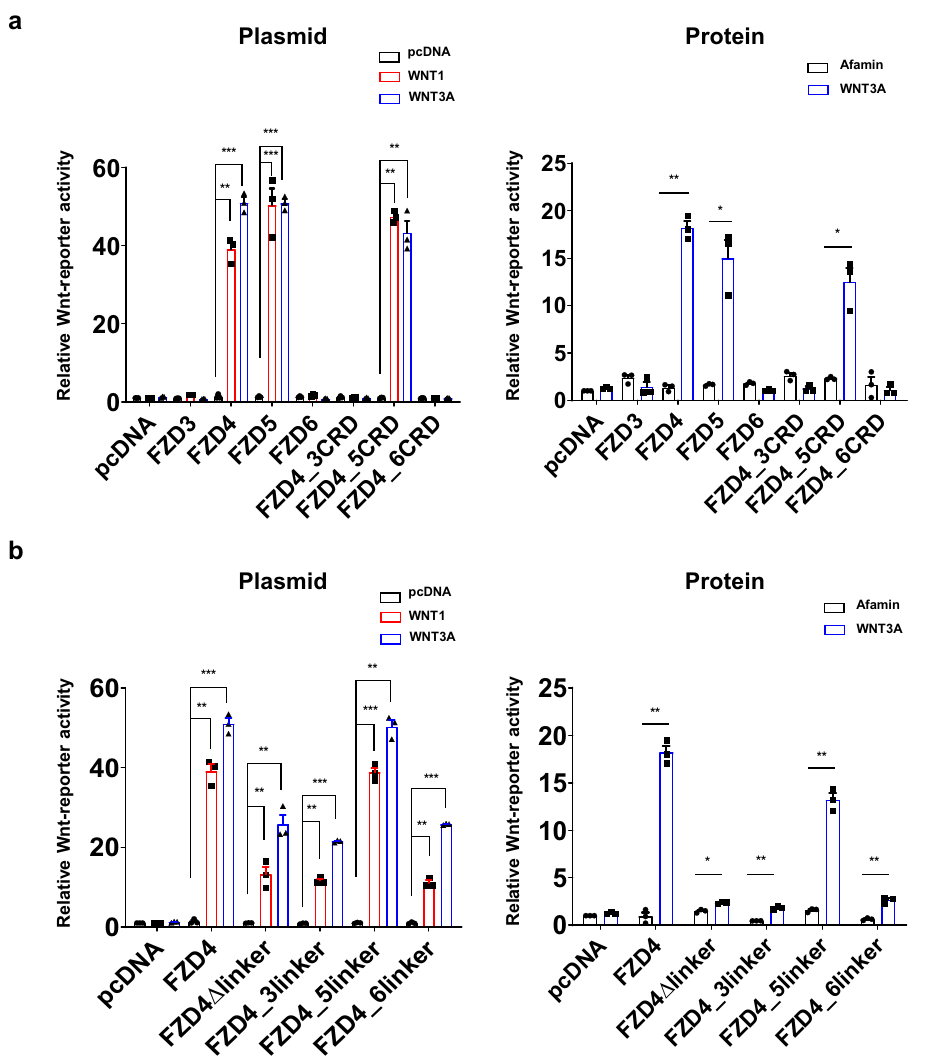
Fig. 2 Canonical signal activity of FZD linker swap mutants. The effects of various FZD4 mutants on WNT1 and WNT3A signaling were observed using TOPFlash assays. The bar graphs show the results of plasmid transfection (left) and protein treatment (right) for ( a ) CRD-swapped mutants and ( b ) linker- swapped mutants of FZD4. The error bar indicates the SEM (standard error of mean) of three independent experiments. Statistical comparisons were performed using the two-tailed t -test. ‘ *** ’ represents P < 0.001, ‘ ** ’ represents P < 0.01, and ‘ * ’ represents P < 0.05 for TOPFlash assays on various FZD4 CRD and linker-swapped